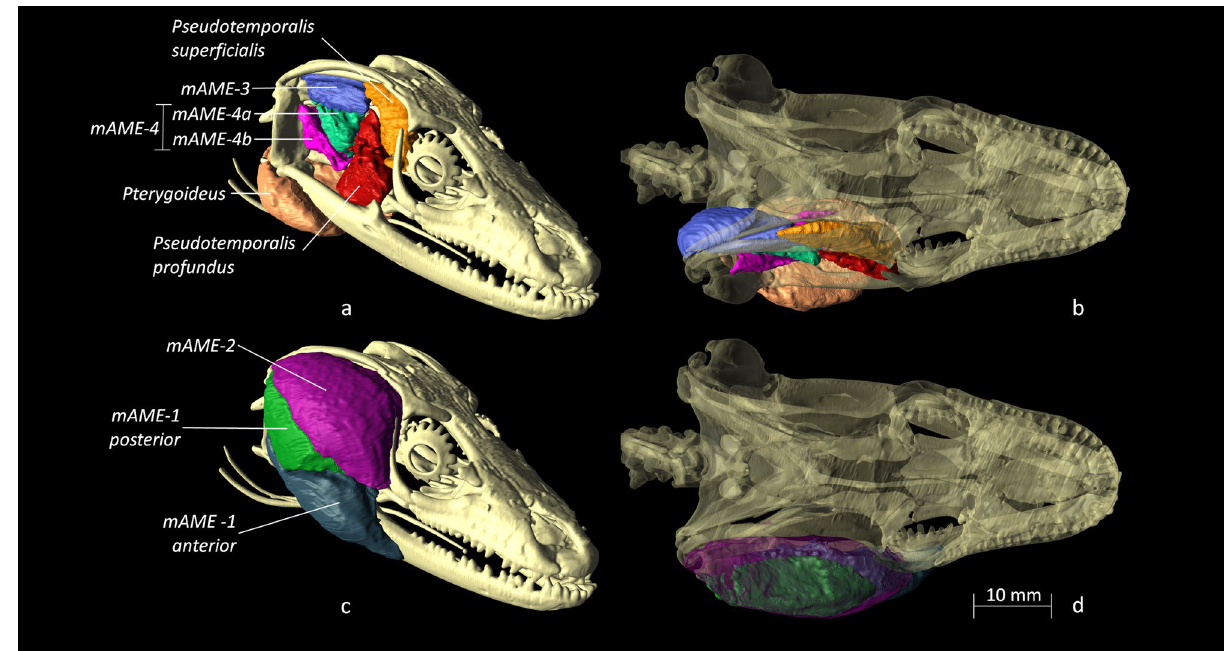
Figure 3. Reconstruction of the three major groups of jaw adductors from CT and MRI scanning and segmentation of the holotype of Phoboscincus bocourti. ( a , b ) Lateral and dorsal views of the most internal sets of jaw adductors: pseudotemporalis complex composed by the muscles pseudotemporalis profundus in red, pseudotemporalis superficialis in orange. The m. pterygoideus is colored in salmon. The medial portion of the mAME medialis (mAME-3) is shown in blue. The mAME profundus (mAME-4) complex is also composed by two bundles respectively colored in aquamarine green (mAME-4a) and fuchsia (mAME-4b). ( c , d ) lateral and dorsal views of the mAME superficialis (mAME-1) and the radial portion of the mAME medialis (mAME-2) complexes. The mAME-1 is composed by the anterior bundle (dark blue) and the posterior bundle (dark